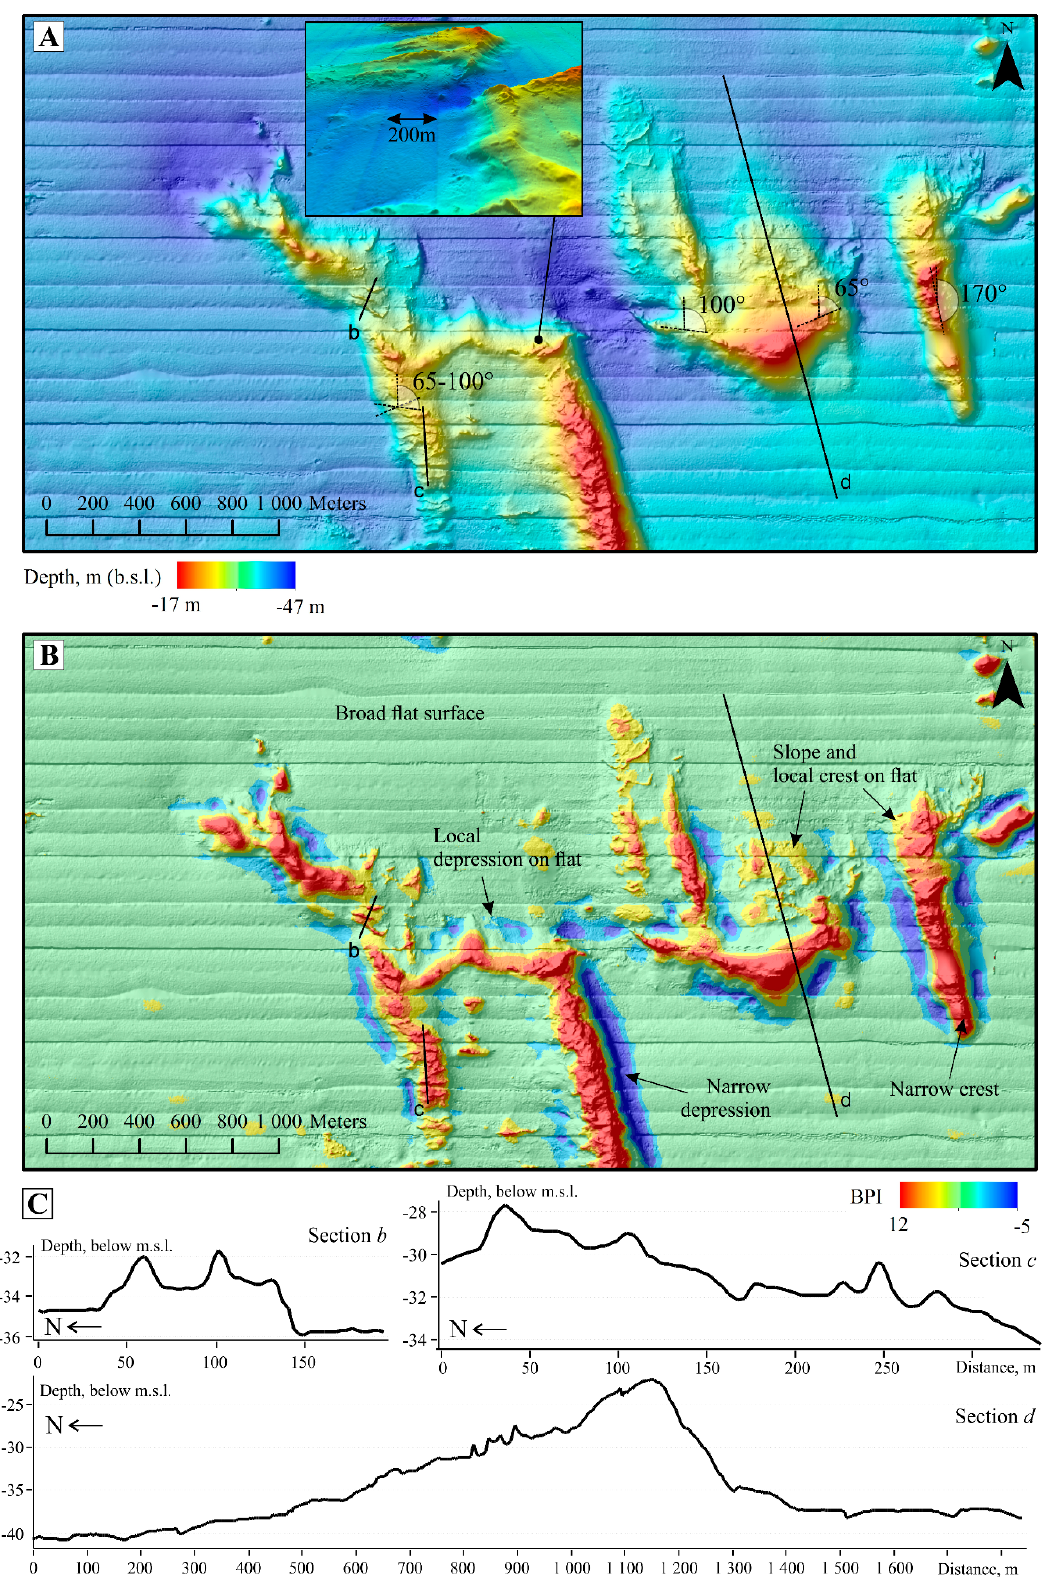
Figure 5. Digital bathymetric model (DBM) of the Vyborg Bay key area; ( A ) MBES image; ( B ) BPI; ( C ) bathymetric profiles across high relief forms.